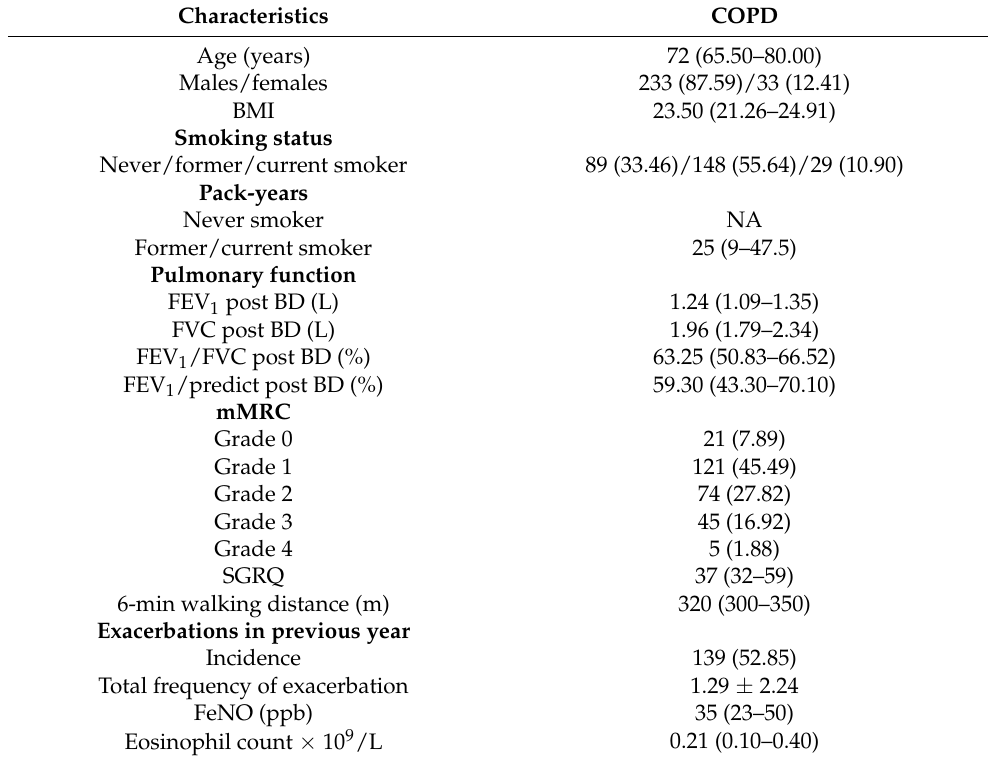
Table 1. Baseline characteristics of the 266